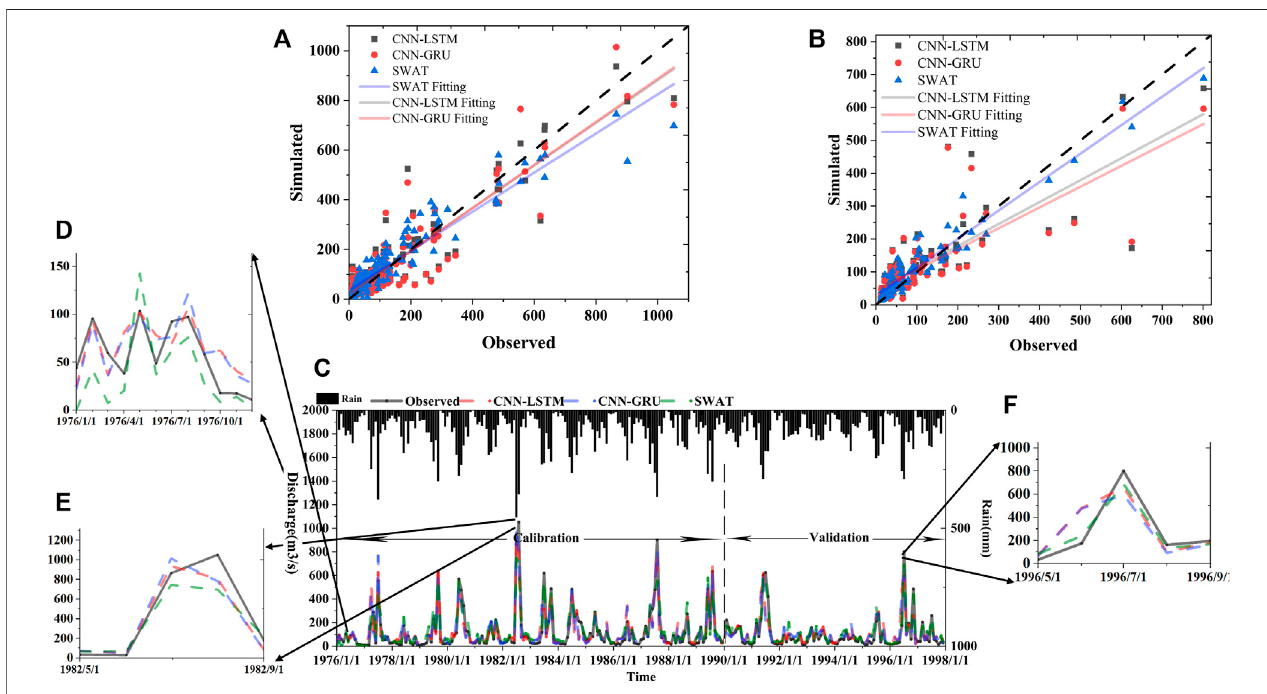
FIGURE 8 | Simulated results of deep learning models and hydrological model (the scatters of different models in (A) calibration and (B) validation period; the discharges hydrographs in (C) 1976 – 1997, (D) 1976, (E) 1992, and (F) 1997 years).